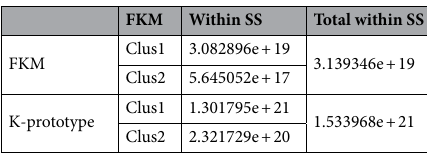
Table 4. FKM and K-prototype sum of squares.